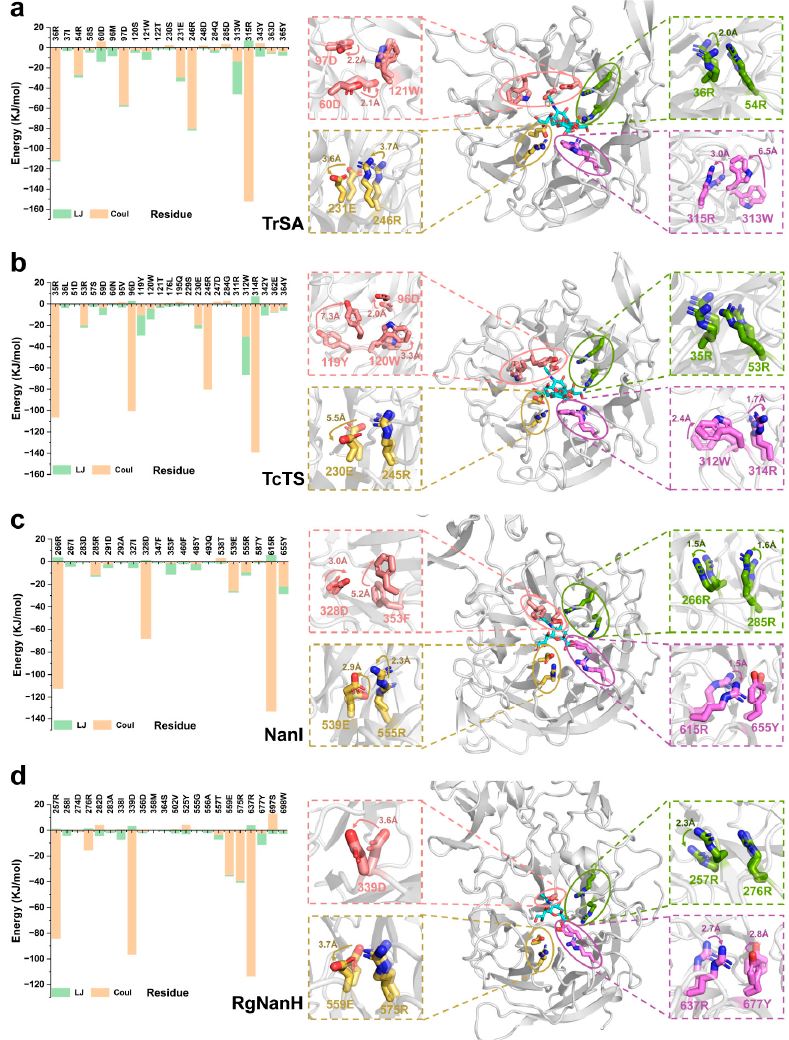
Figure 5. Interaction energy between the substrate and GH33 sialidases and the conformational transitions of the active site residues. The conformational changes of key residues are analyzed by comparing the MD structures with the PDB structure. LJ: hydrophobic interactions; Coul: electro ‐ static interactions. The orientation directions of the residues are shown with arrows and the changed distances are labelled. Interaction energy between the substrate and TrSA, TcTS, NanI and RgNanH and the conformational transitions of the active site residues are shown in ( a – d ), respectively.